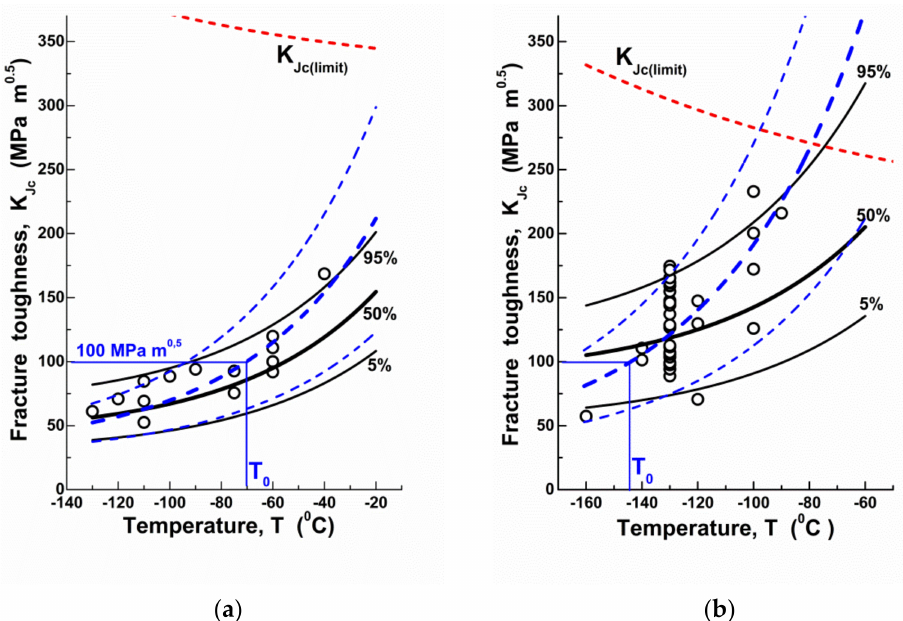
Figure 4. (Colour online). The temperature dependences of fracture toughness K Jc for RPV steel ( a ) and cast low-alloyed manganese steel ( b ): circles show the experimental evidence, lines are the calculation results (solid black lines are the results of K Jc calculation accounting for the CN density ρ and dashed blue lines are the results of K Jc calculation by the Master Curve method); T 0 is the reference temperature (short-dashed red lines are the temperature dependences of elastic plastic fracture toughness validity limit K Jc ( limit ) ), calculated according to Equation (14). Table 2. Mechanical properties of the tested steels ( σ 0.2 is the yield strength determined as 0.2